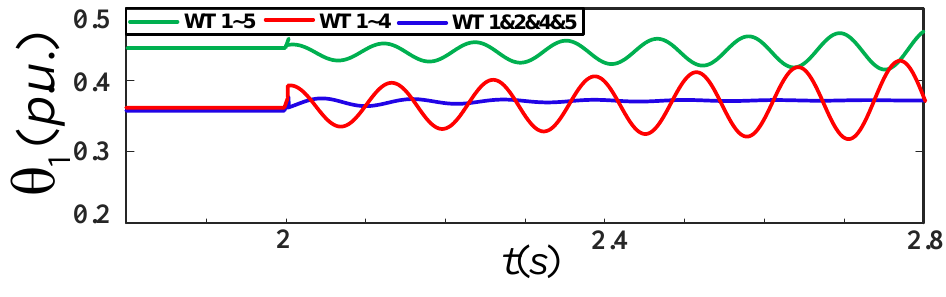
Figure 7. Time domain responses of θ of WT 1 connected to different quantities of WTs.